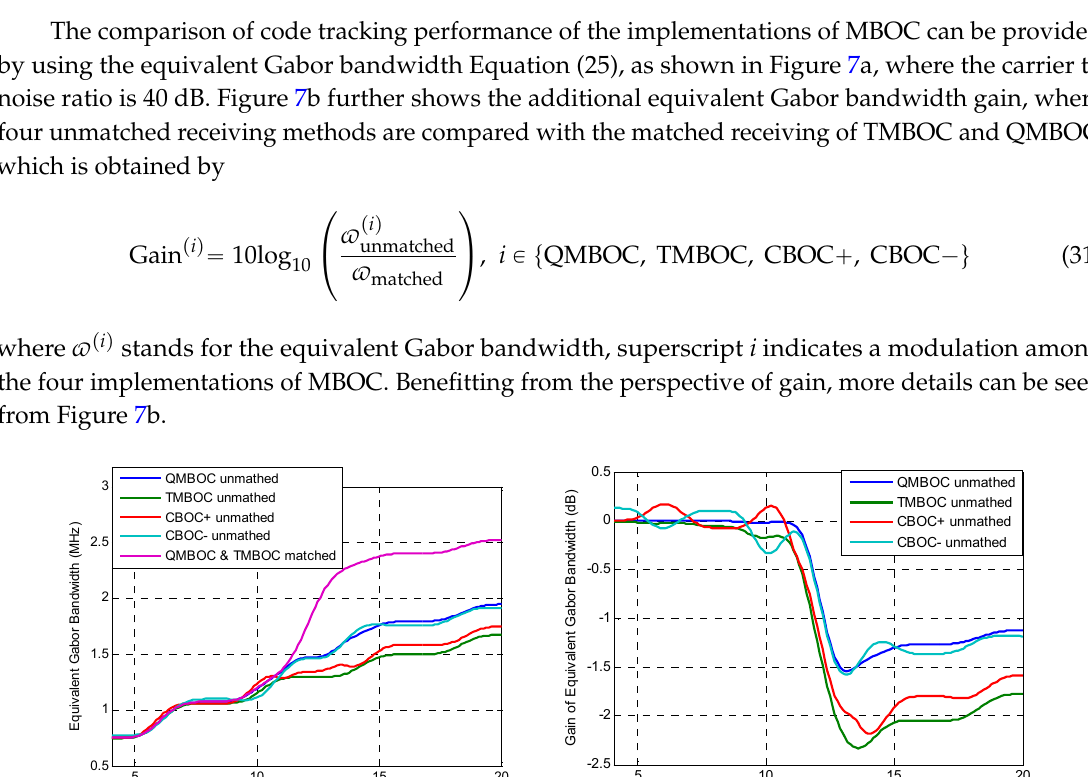
Figure 6. The correlation output SNIR loss of multiple implementation of MBOC(6,1,1/11) signals, under matched receiving and BOC 11 -like unmatched receiving. It can be used to characterize the acquisition performance of MBOCs.